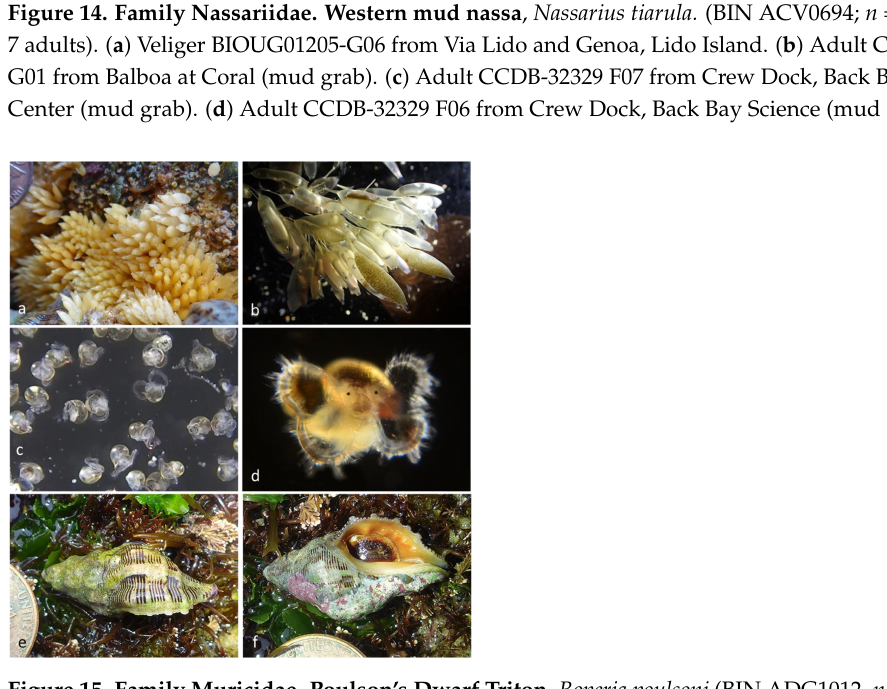
Figure 15. Family Muricidae. Poulson’s Dwarf Triton , Roperia poulsoni (BIN ADG1012, n = 6 adults, 2 veligers, 1 eggs). ( a ) Eggs CCDB 31597 C05 from Ocean off Dana Point. ( b ) Egg cases containing veligers, Gast14_A01—A03. Reef Point, Crystal Cove State Beach, Orange County, CA. 5/17/2021. ( c ) escaped veligers. ( d ) Veliger BIOUG01229-H10 from Newport Harbor entrance. ( e ) Adult CCDB 31729 B12 from Crescent Beach. ( f ) Adult CCDB 31729 B08 from Crescent